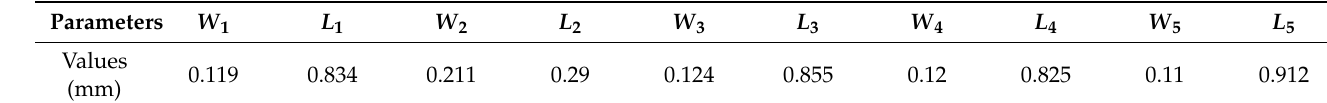
Figure 8. Layout of the type-1 crossover in ADS.